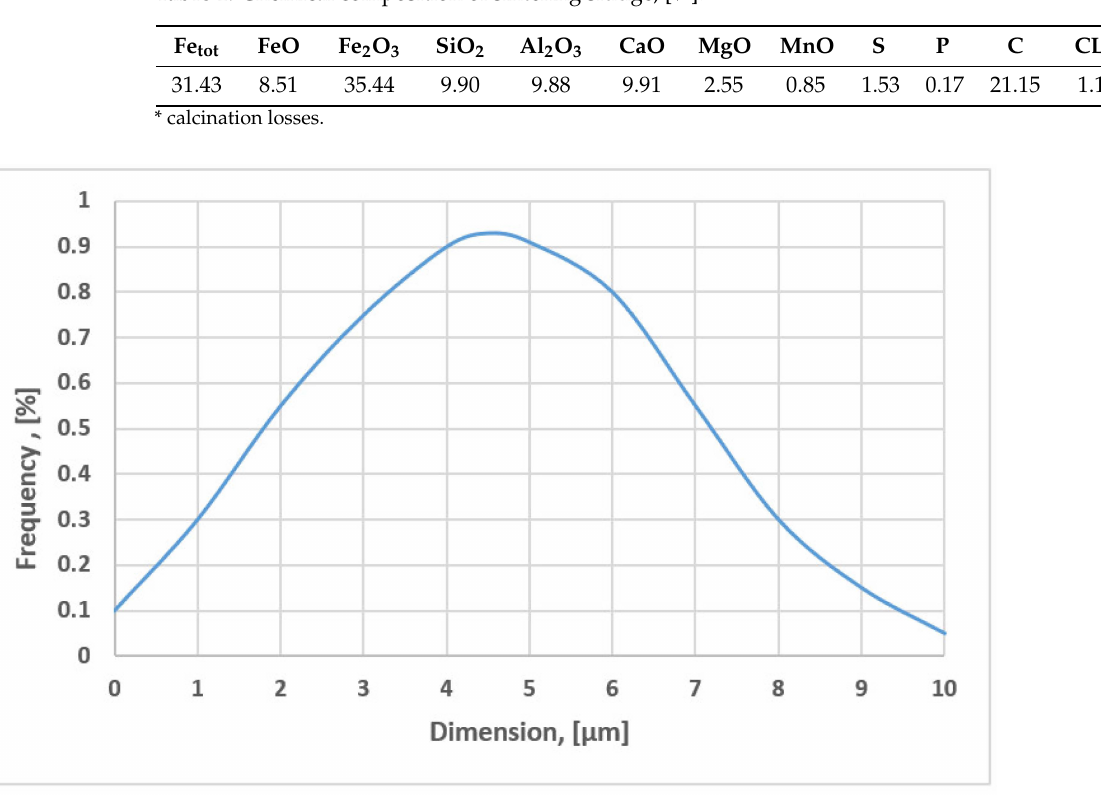
Figure 2. Distribution of particle size classes for sintering sludge, class 0–10 µ